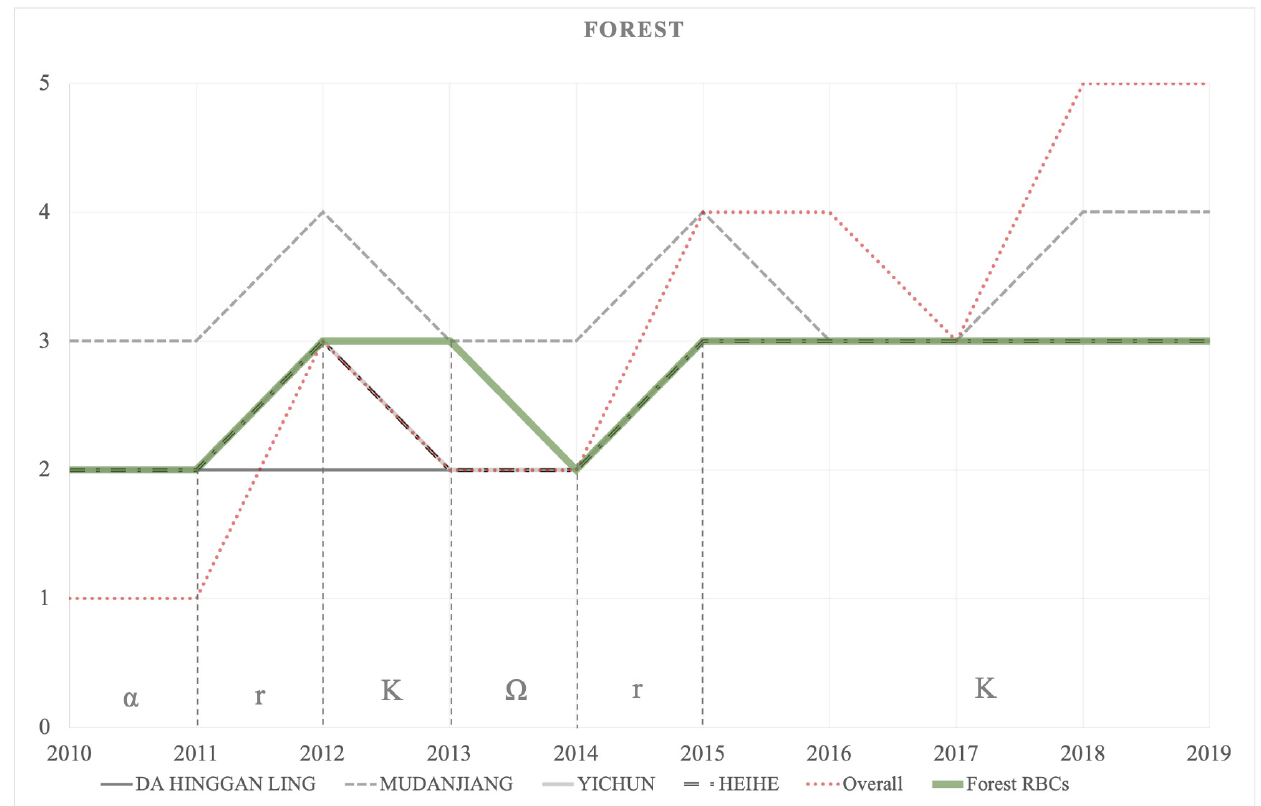
Figure 10. Resilience dynamics of forest-based cities from 2010 to 2019.